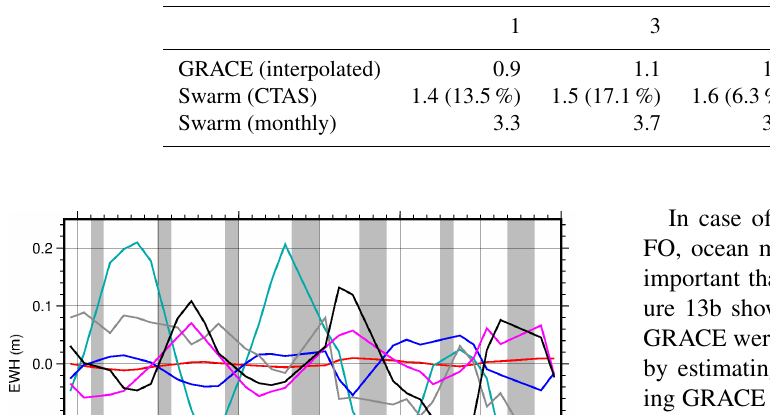
Table 9. Mean RMSE (mm) of the gap-filler methods with respect to existing GRACE data. The columns indicate the number of missing months. The percentage of Swarm (CTAS) solutions with a lower RMSE than GRACE (interpolated) solutions is indicated in parentheses. To derive the value in parentheses, we counted the number of CTAS solutions with a lower RMSE than GRACE (interpolated) and computed the relation to the absolute number of CTAS solutions. The number of investigated solutions decreases from left to right, as the time span becomes longer.